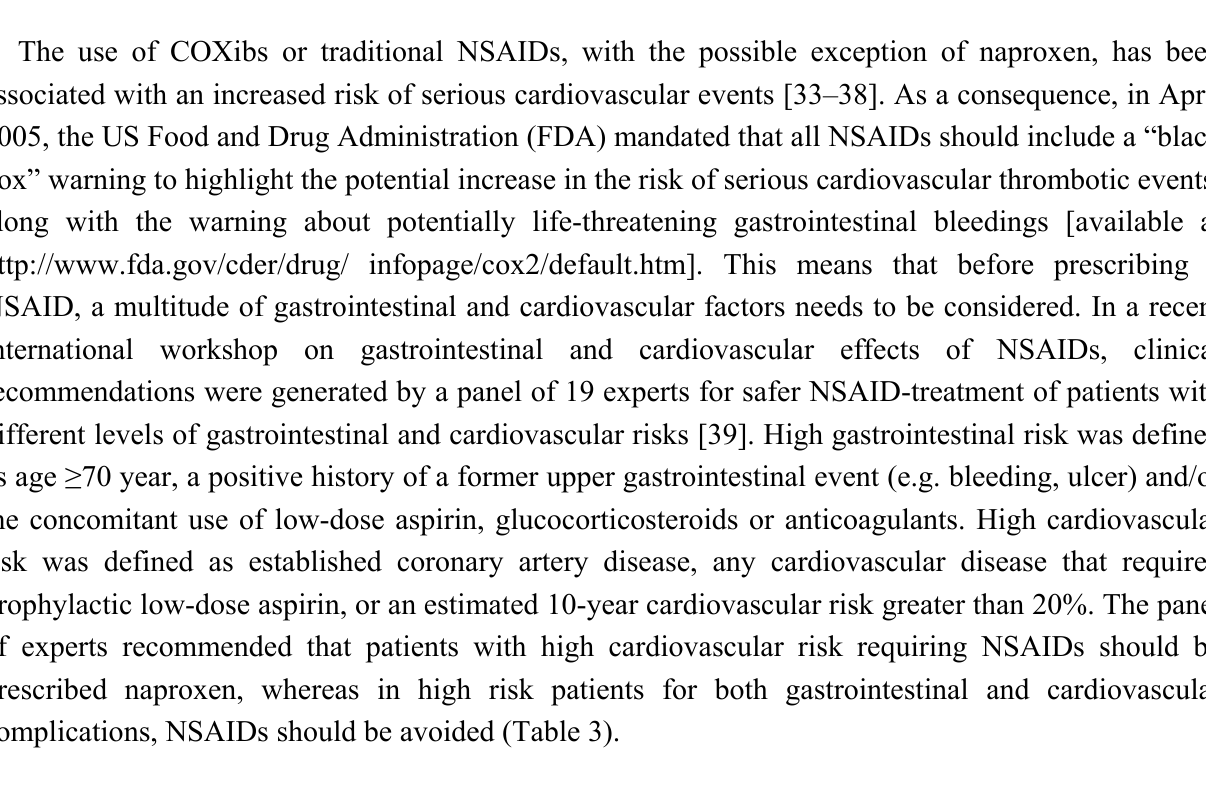
Table 3. Algorithm for NSAID prescription based on gastrointestinal and cardiovascular risk